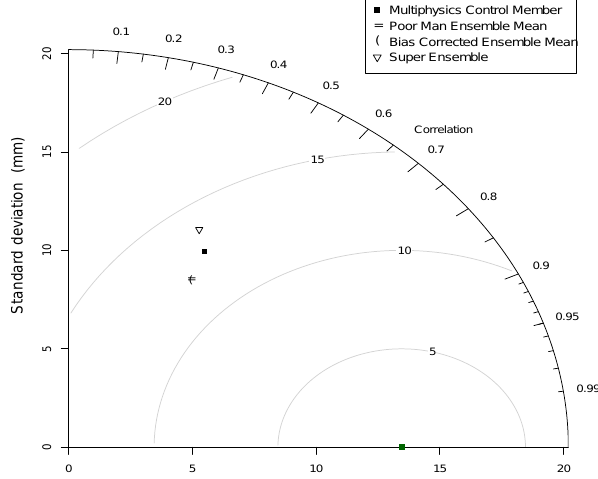
Fig. 4. Taylor diagram for the multiphysics ensemble control member, the multiphysics ensemble mean, the bias corrected ensemble mean and the superensemble, as functions of different rainfall event thresholds.